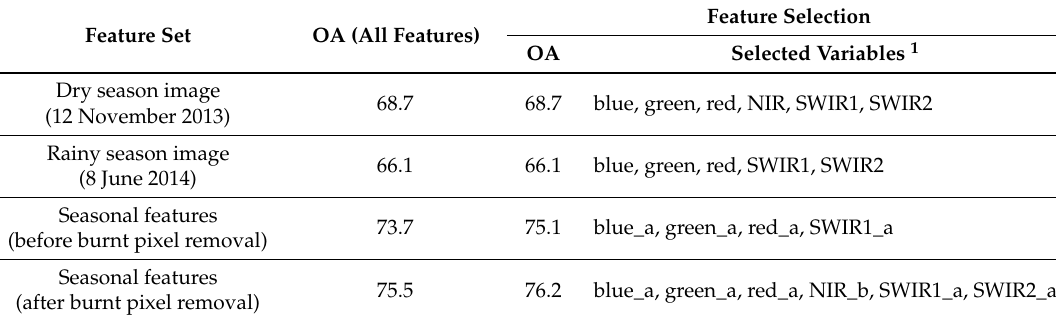
Table 2. Overall accuracy (OA, %) for the land cover classifications.